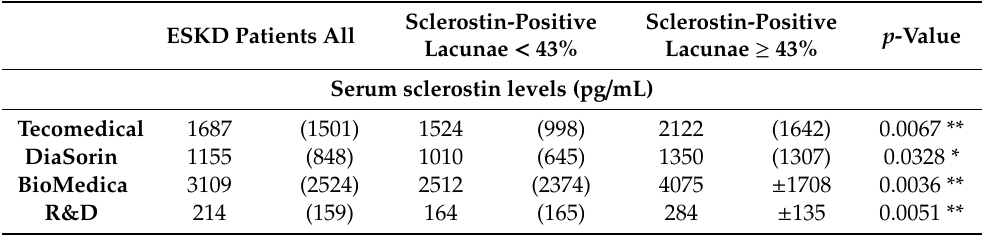
Table 5. Skeletal sclerostin explained between 12%–16% of the variability of circulating